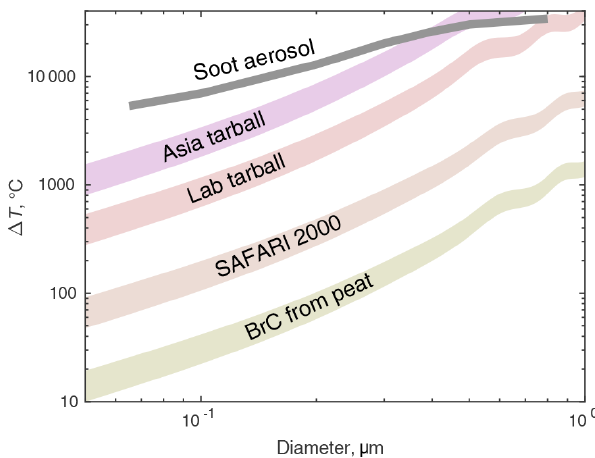
Figure 10. Estimates of particle heating from Eq. (1) for several particle composition types. MSTM was used to find Q abs for the soot aerosol, while Mie theory was used for the other materials. See Table 1 for the refractive indices used. Shaded regions indicate uncertainty bounds for the accommodation coefficient α ranging from 1 (bottom) to 0.5 (top). The mean free path L was calculated at 700hPa, near the median pressure during the DMA → UHSAS tests. The soot aerosol line uses α = 0 . 53, as in Fig. 5, but the lower pressure yields temperatures about 1000K